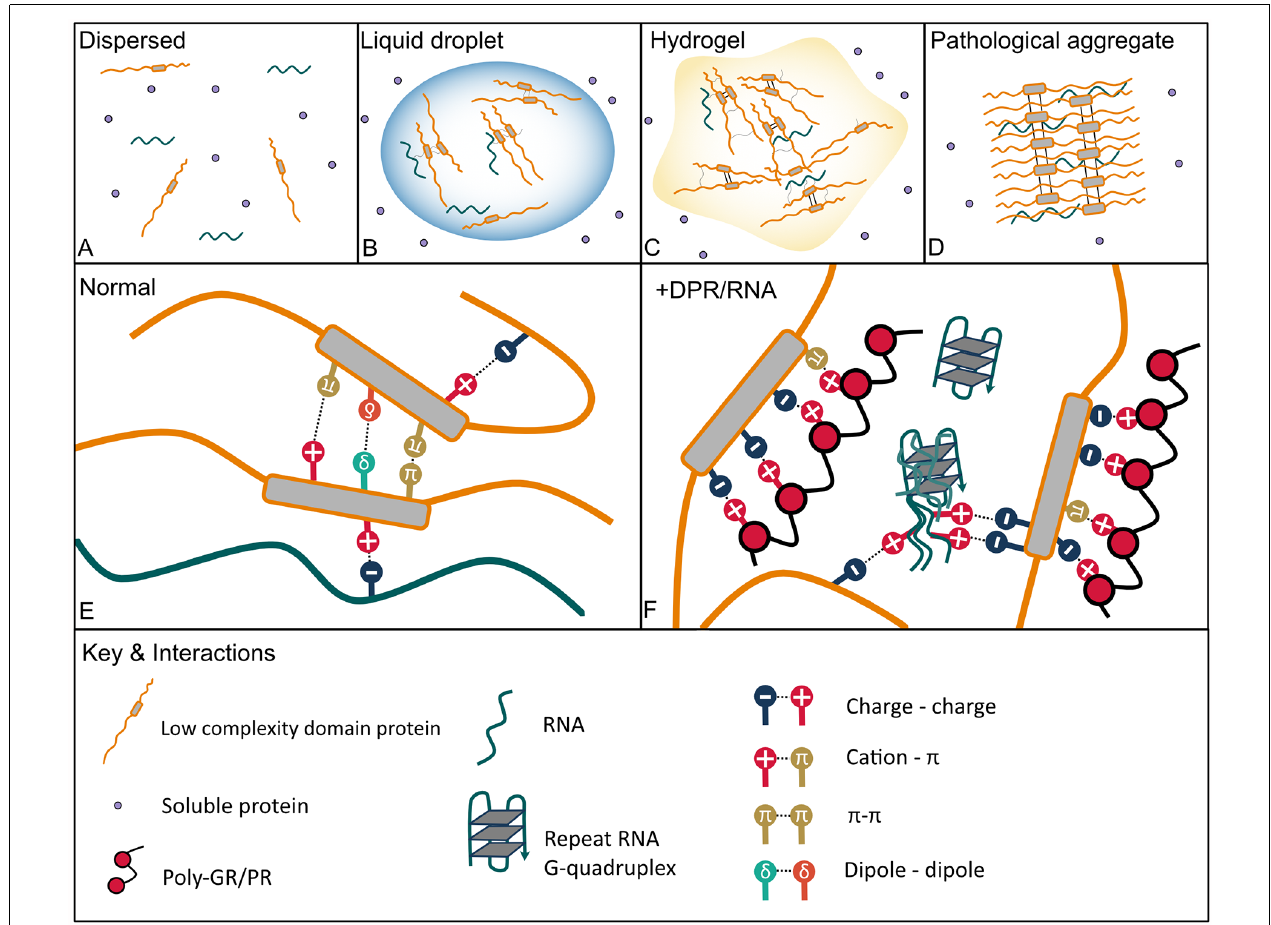
FIGURE 1 | Protein phase transition states and interactions with C9orf72 arginine rich dipeptide repeat proteins (DPRs) and GGGGCC (G 4 C 2 ) repeat RNA that lead to aberrant phase separation. (A) Dispersed—soluble proteins are freely dispersed in a dilute phase. (B) Proteins with intrinsically disordered regions such as low complexity domains (LCDs) can de-mix from a dilute phase often in the presence of RNA through liquid-liquid phase separation (LLPS) to form dynamic liquid droplets in which molecules can still diffuse in and out and disperse rapidly. (C) Liquid droplets can transition into more solid-like hydrogels which consist of amyloid-like fibrils, which are less dynamic but still reversable. (D) Aberrant phase separation facilitates the formation of pathological permanent amyloid fibrils which are the constituents of aggregates found in neurodegenerative disease brain. (E) Physiological interactions that mediate LLPS include pi ( π )– π , cation– π , polar (dipole-dipole), charge-charge interactions in addition to hydrophobic and π -sp2 interactions, and hydrogen bonding (not shown). (F) The arginine-rich DPRs mimic physiological interactions driving aberrant phase separation with the arginine residues acting as the cation in electrostatic interactions, both charge-charge and with aromatic side chains within LCDs (cation- π ). The G 4 C 2 repeat RNA can also undergo charge-charge interactions with LCDs; further G 4 C 2 G-quadruplexes may enhance RNA-RNA and RNA-LCD interactions and nucleate droplet formation by cellular